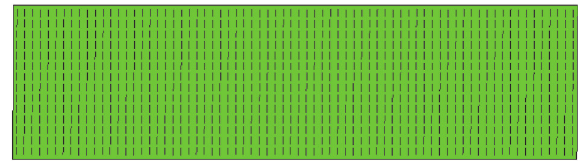
Figure 15: Model of the wire antenna array.